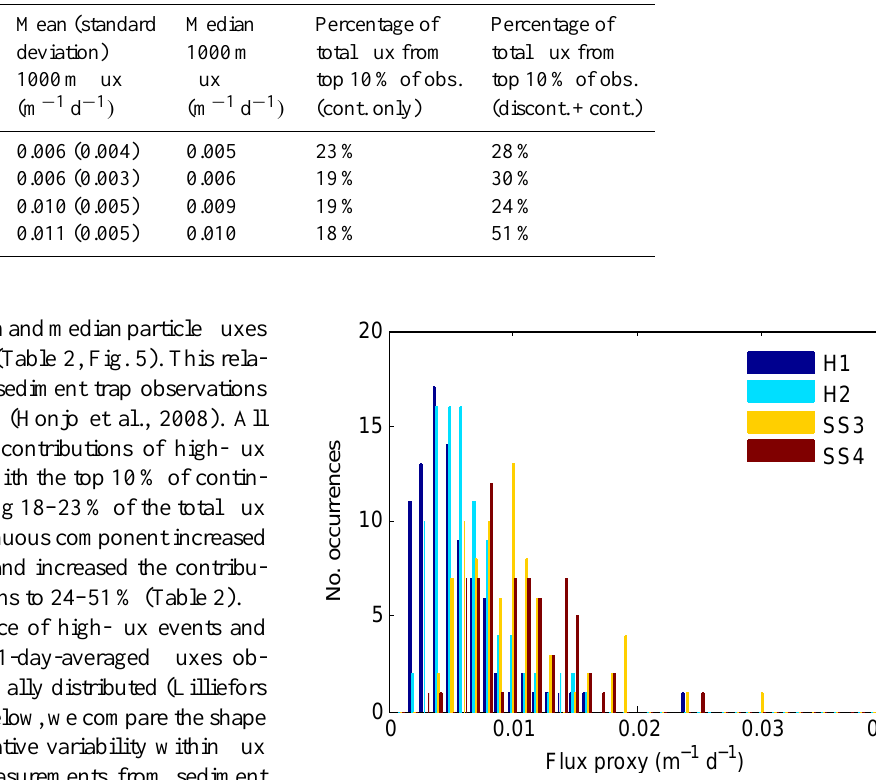
Fig. 5. Histogram of continuous flux proxy data from floats H1–SS4 (Table 1). Data were bin-averaged to